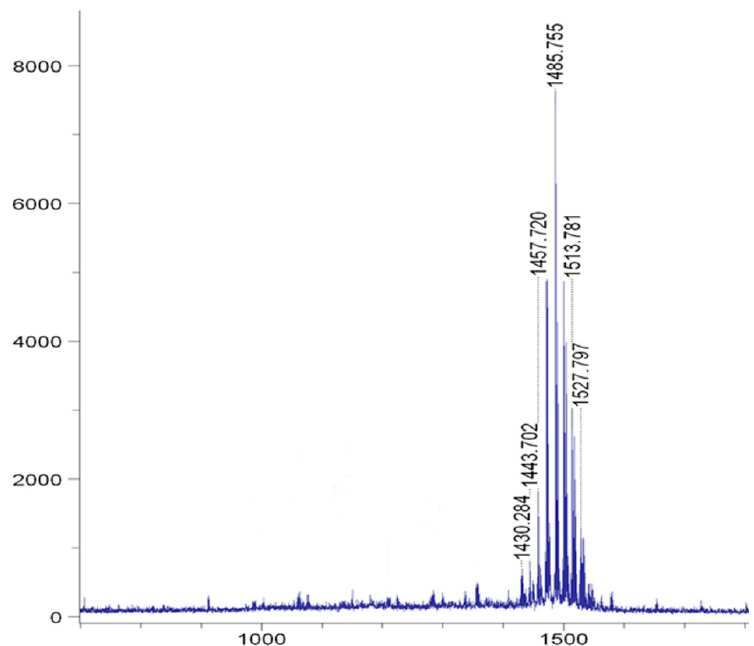
Figure 3. MALDI-TOF mass spectra of purified fengycin from AK1S mutant. C14, C16, and C17 homologues of fengycin were detected. The peaks in a range of masses from 1400 to 1600 m / z represent fengycin.